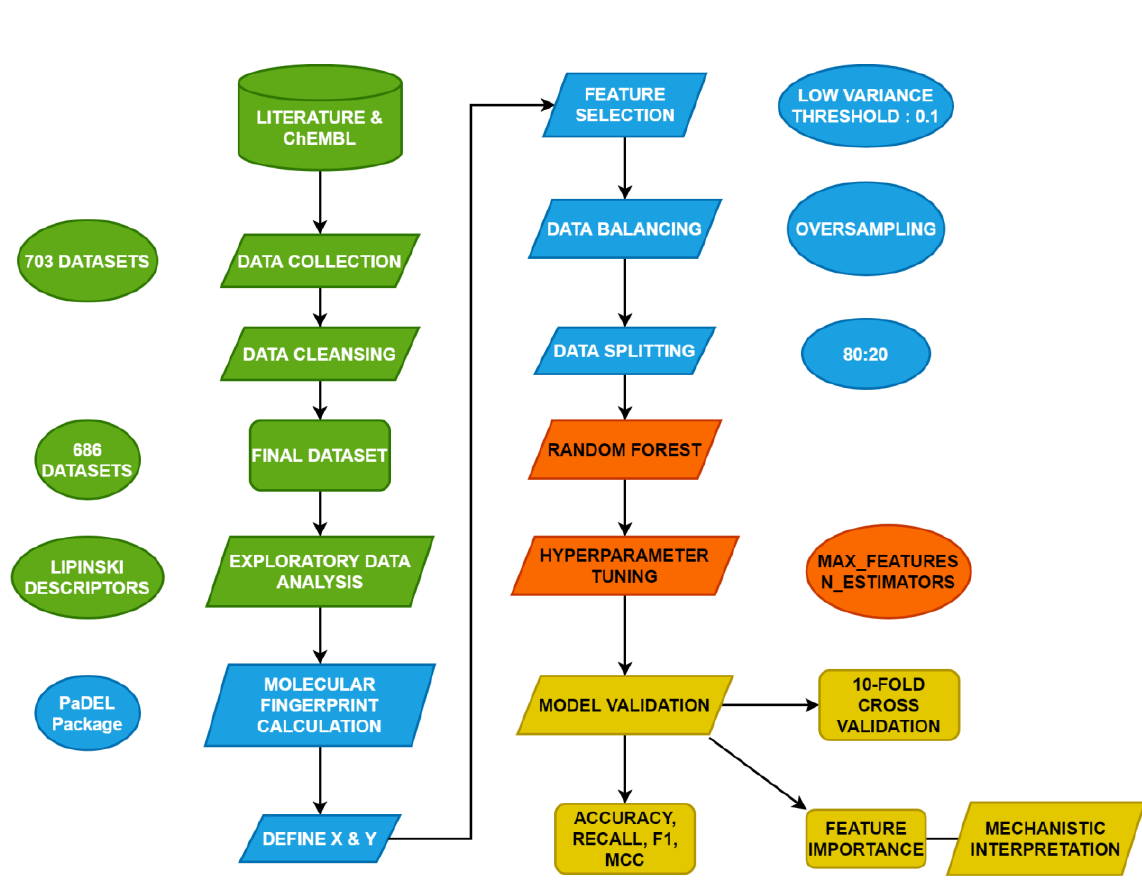
Figure 1: Schematic diagram of the conceptual framework of this study. Different colors symbolize various steps of the study. Green means data collection and data cleansing, blue means descriptor calculation, red means QSAR modeling and orange means validation and mechanistic